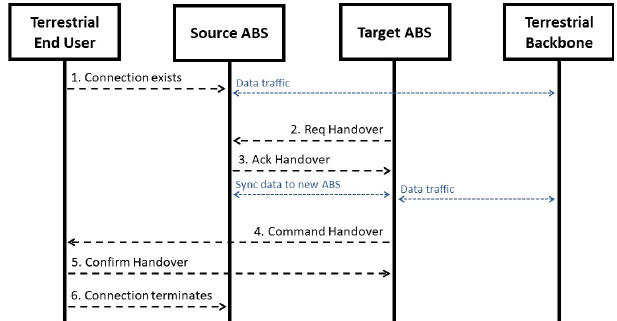
Figure 3. A single handover procedure between ABSs is labeled with numbers in the figure. Firstly, there is an ongoing connection between a terrestrial user and an ABS with drained battery, the source ABS in the figure, and the data tra ffi c is delegated to the terrestrial backbone through the connection.